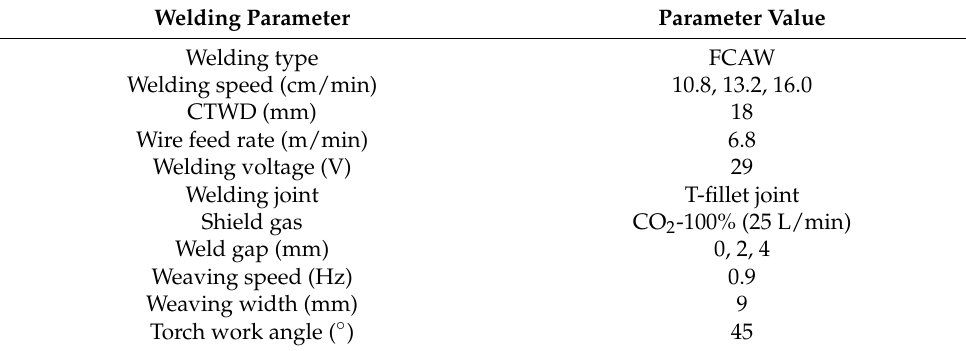
Table 2. Welding experiment conditions.